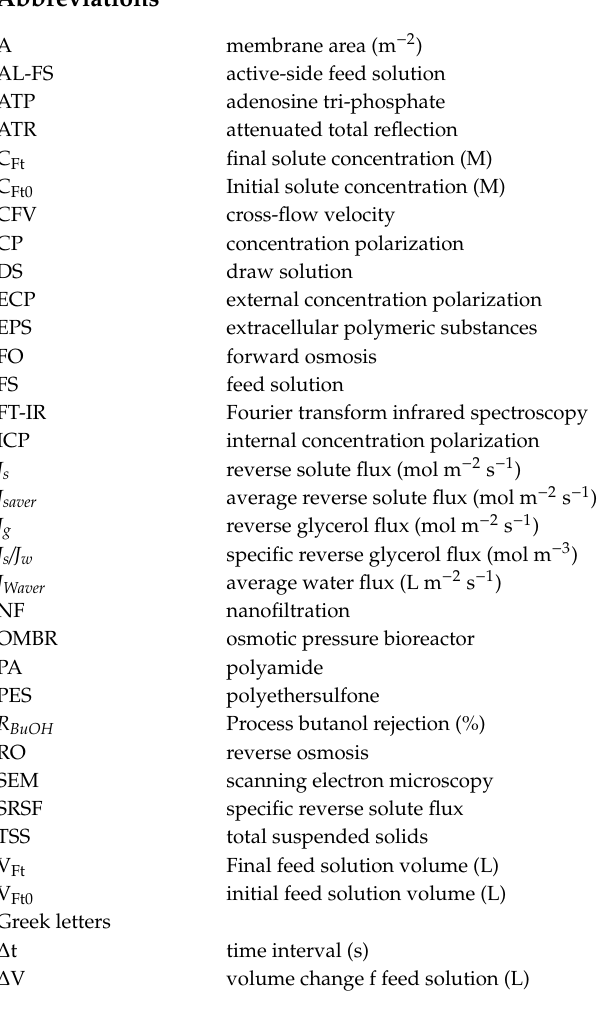
Figure S1. SEM image of active side of Aquaporin InsideTM membrane surface (set-up 4). (A) 5000 magnification, (B) 15000 magnification; Figure S2. SEM image of active side of Aquaporin InsideTM membrane surface (setup 1); Figure S3. SEM image of active side of Aquaporin InsideTM membrane surface (set-up 2); Figure S4.